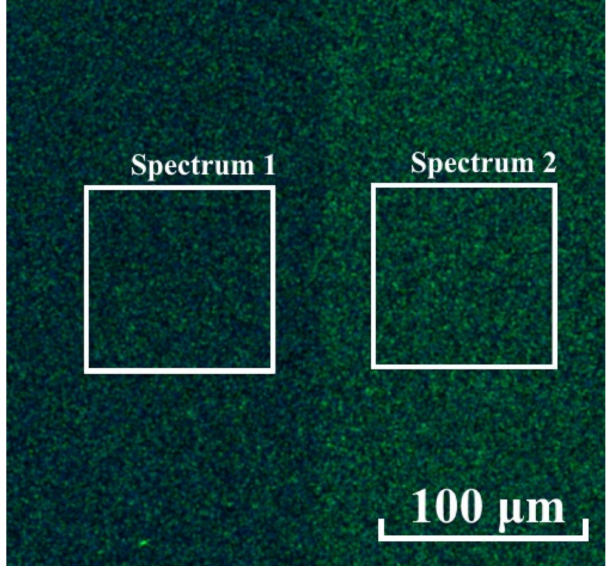
Figure 10. EDX mapping for the cluster ion-treated area (left) and untreated area (right). Furthermore, a lamella was prepared from the treated area of the sample. On the sur- face of the lamella, a protective platinum deposition was applied, produced in the column of the microscope. Then, the lamellae were mounted on a grid for electron microscopy and further thinning to a thickness of approximately 100 nm with an ion beam. The